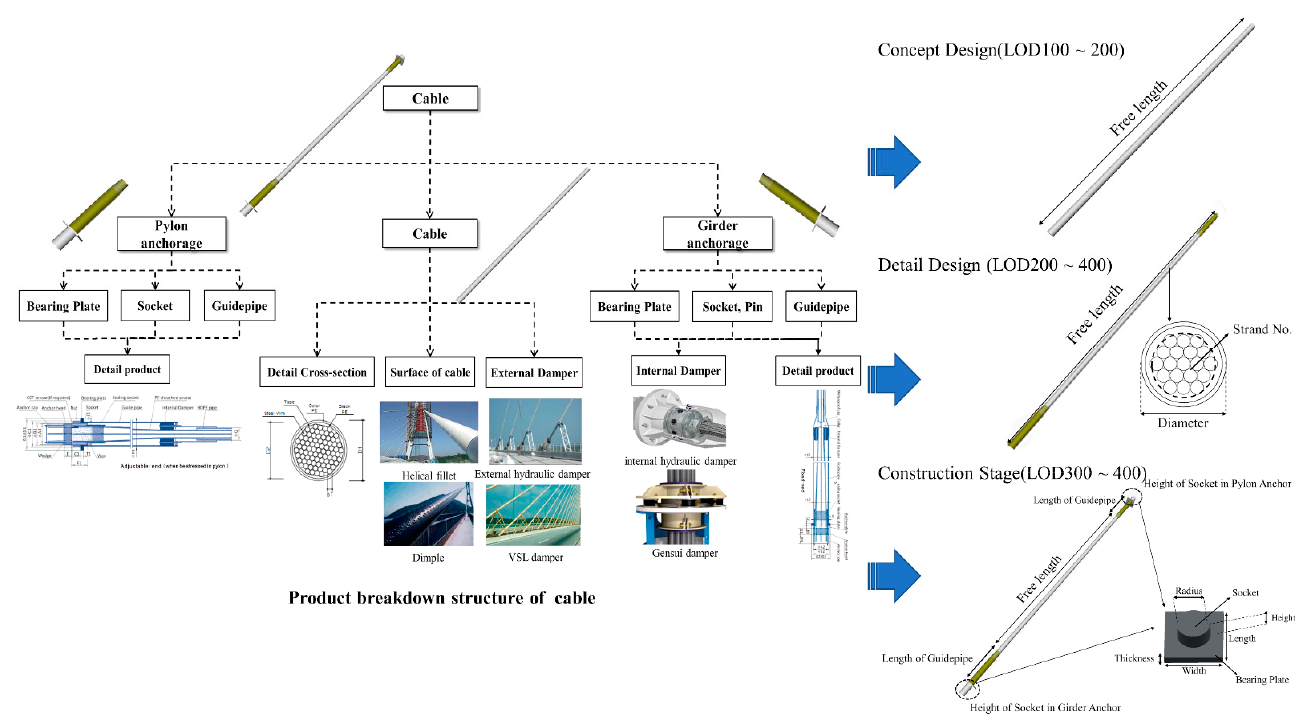
Figure 2. Definition of a cable model according to levels of details (LOD).